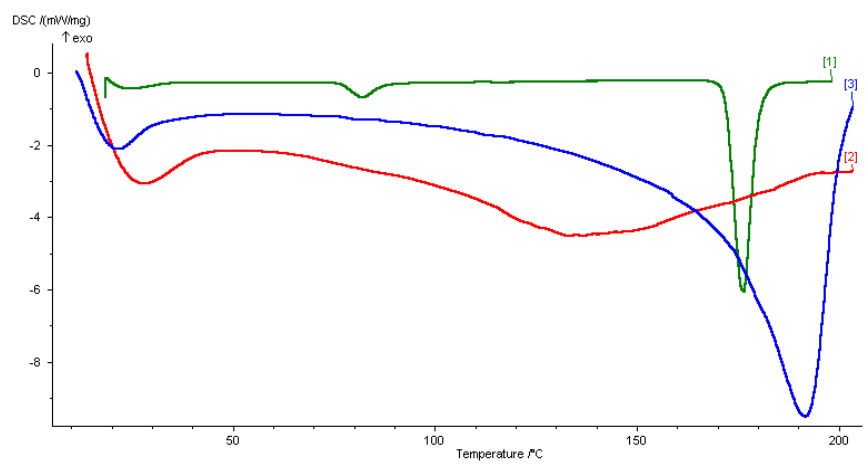
Figure 1. DSC thermograms of ( 1 ) dapsone, ( 2 ) drug-DES mixture, and ( 3 ) CC:PG DES.